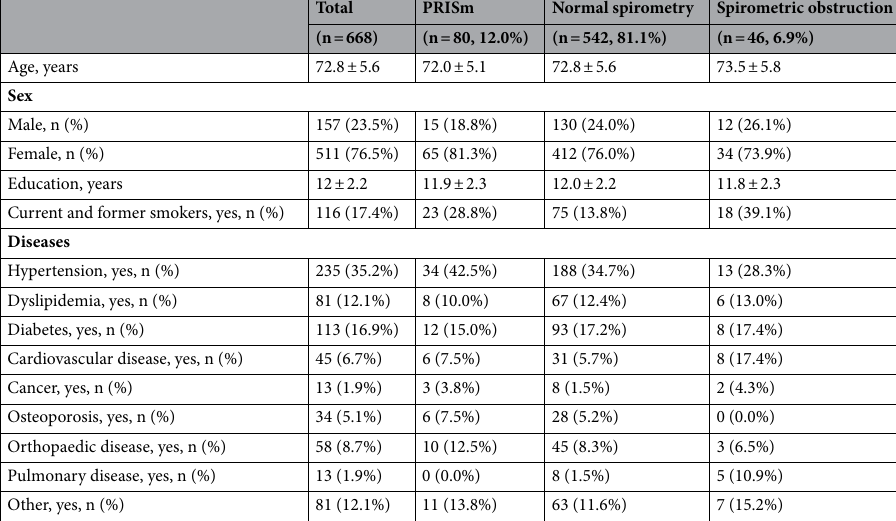
Total PRISm Normal spirometry Spirometric obstruction (n =